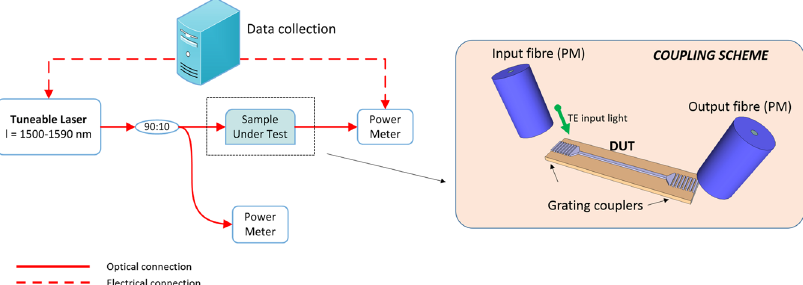
Figure 3. Propagation loss experimental scheme. PM: Polarization Maintaining; DUT: Device Under Test.